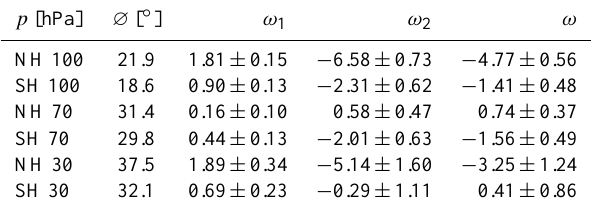
Table 2. Average turn-around latitude per level and hemisphere and corresponding linear trend coefficients obtained from the regression analysis (Fig. 6). The unit of the trends is degree per